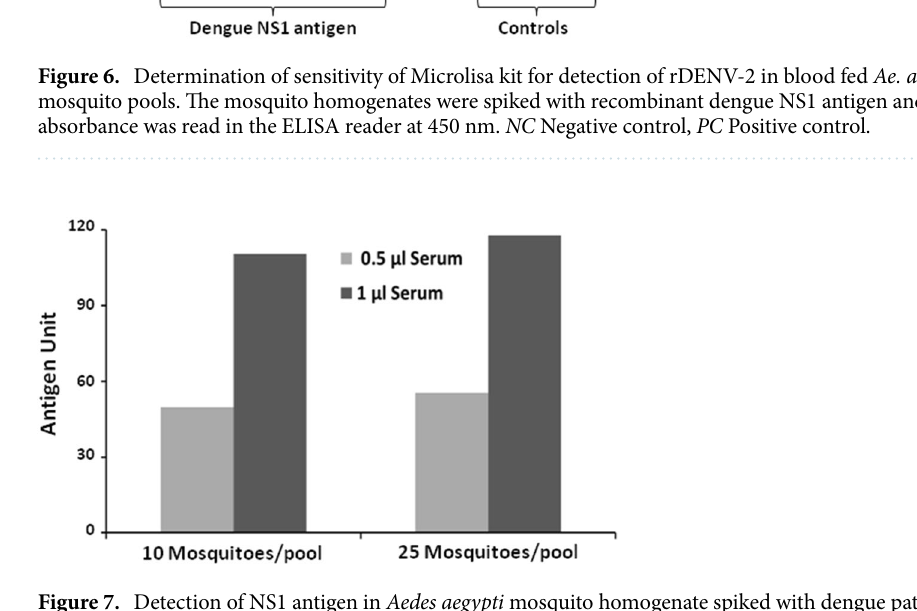
Figure 7. Detection of NS1 antigen in Aedes aegypti mosquito homogenate spiked with dengue patient serum. The dengue confirmed patient serum was spiked with mosquito homogenate and ELISA was performed. OD measured at 450 nm was interpreted in terms of antigen unit as per manufacturer’s